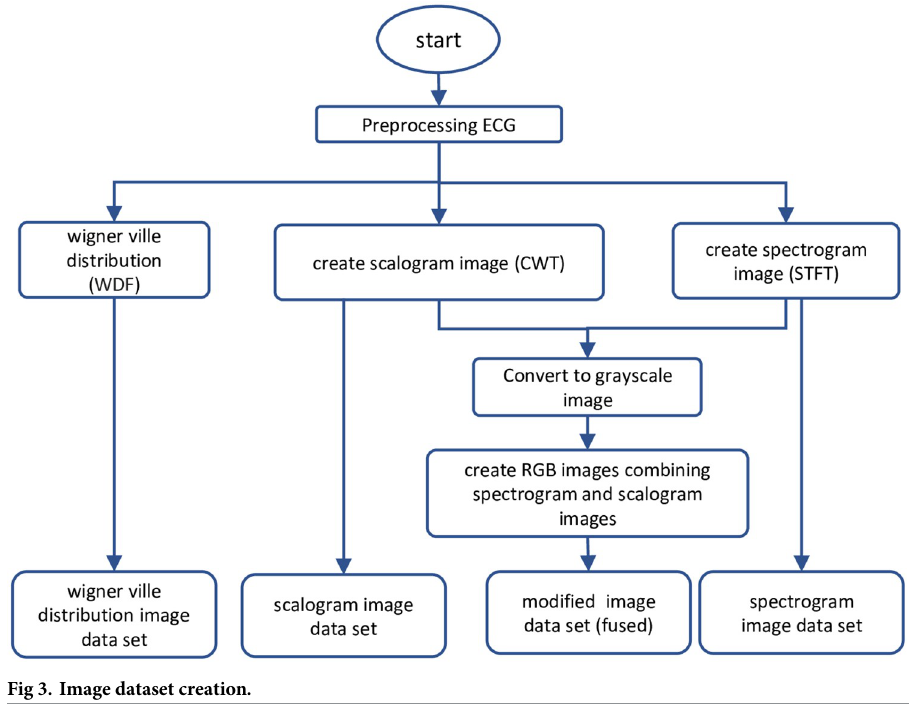
Fig 3. Image dataset